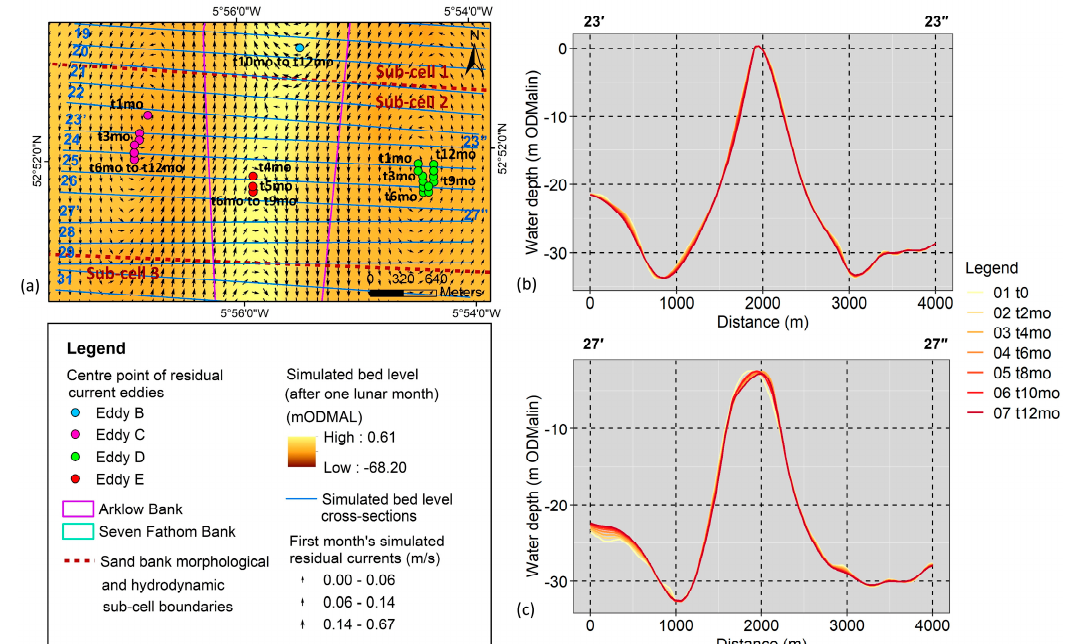
Figure 7. Morphodynamics and hydrodynamics at Sub-cell 2 of Arklow Bank. ( a ) Simulated bed level change after one lunar month and associated residual current vectors, overlain by the location of the centre point of residual eddies from residual currents during each subsequent lunar month simulation; ‘t6mo’ is the sixth lunar simulation month. ( b , c ) Simulated bed level over a one year simulation at cross-sections 23 and 27; ‘t0’ is the starting bed level, and ‘mo’ is subsequent